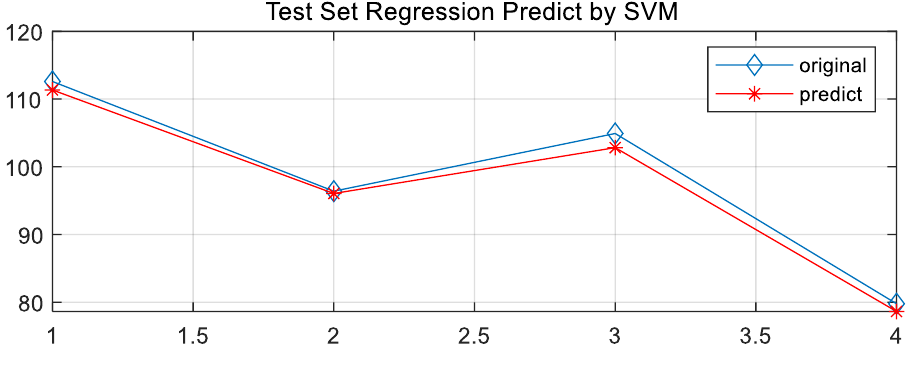
Figure 9. PSO-SVM test set data fit.